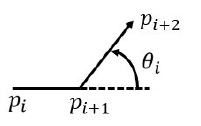
Figure 2. Steering angle. p i ∈ M is the waypoint on the flight path, (cid:107) p i + 1 − p i (cid:107) is the Euclidean distance between two adjacent waypoints on the flight